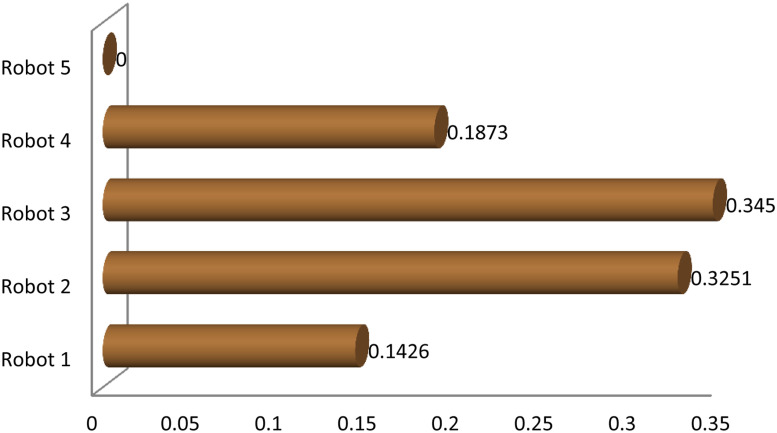
Sensitivity analysis of the criteria C4.